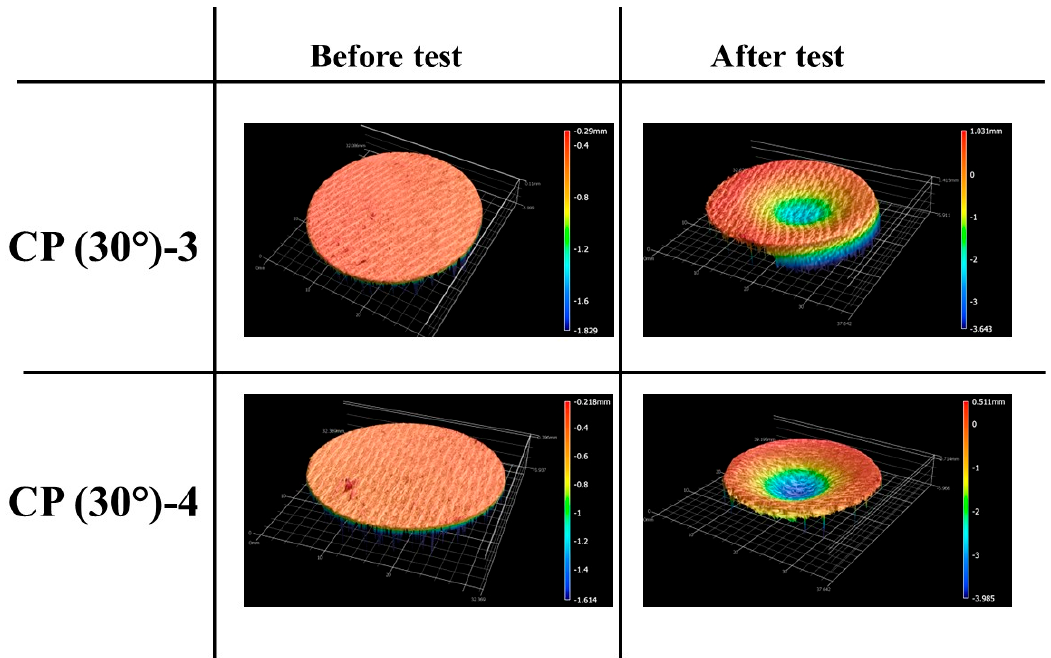
Figure 16. CP (30°)-3 (9 MW/m 2 , 30 s) and CP (30°)-4 (11.5 MW/m 2 , 30 s) exposed surface morphol- ogy changes.